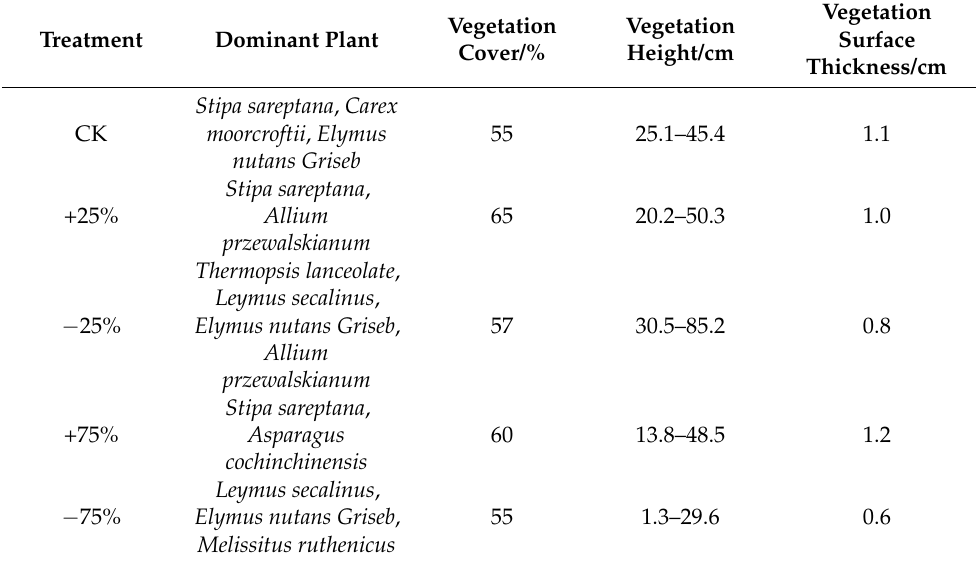
Table 2. August vegetation survey form of the Niaodao Lakeside wetland.